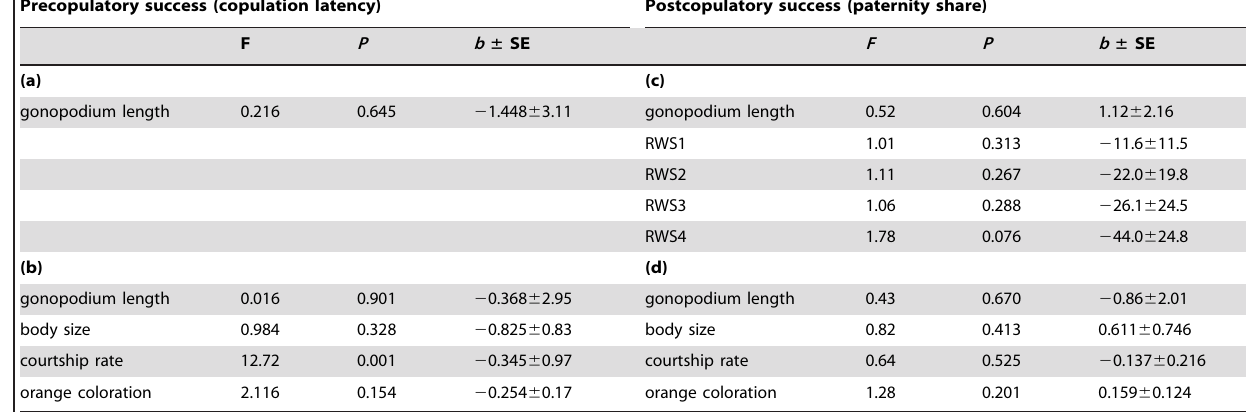
Table 2. Results of regression analysis of pre- and postcopulatory